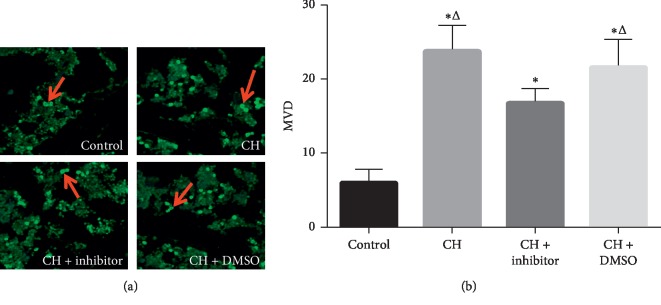
MVD was significantly increased in the bone marrow of the hypoxia groups compared to the control group. Treatment with an STAT3 inhibitor lowered the CH-induced MVD. Control: control group; CH: chronic hypoxia group; CH + inhibitor group: chronic hypoxia + STAT3 inhibitor; and CH + DMSO group. Results are presented as mean ± SEM (n = 6 rats per group). Red arrows indicate MMP-9-positive microvessels. ∗P < 0.05 vs. control; ΔP < 0.05 vs. CH + inhibitor.